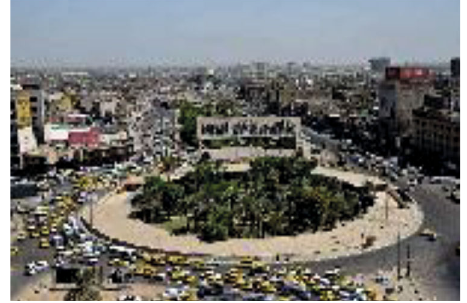
Figure 6: Full color test image.